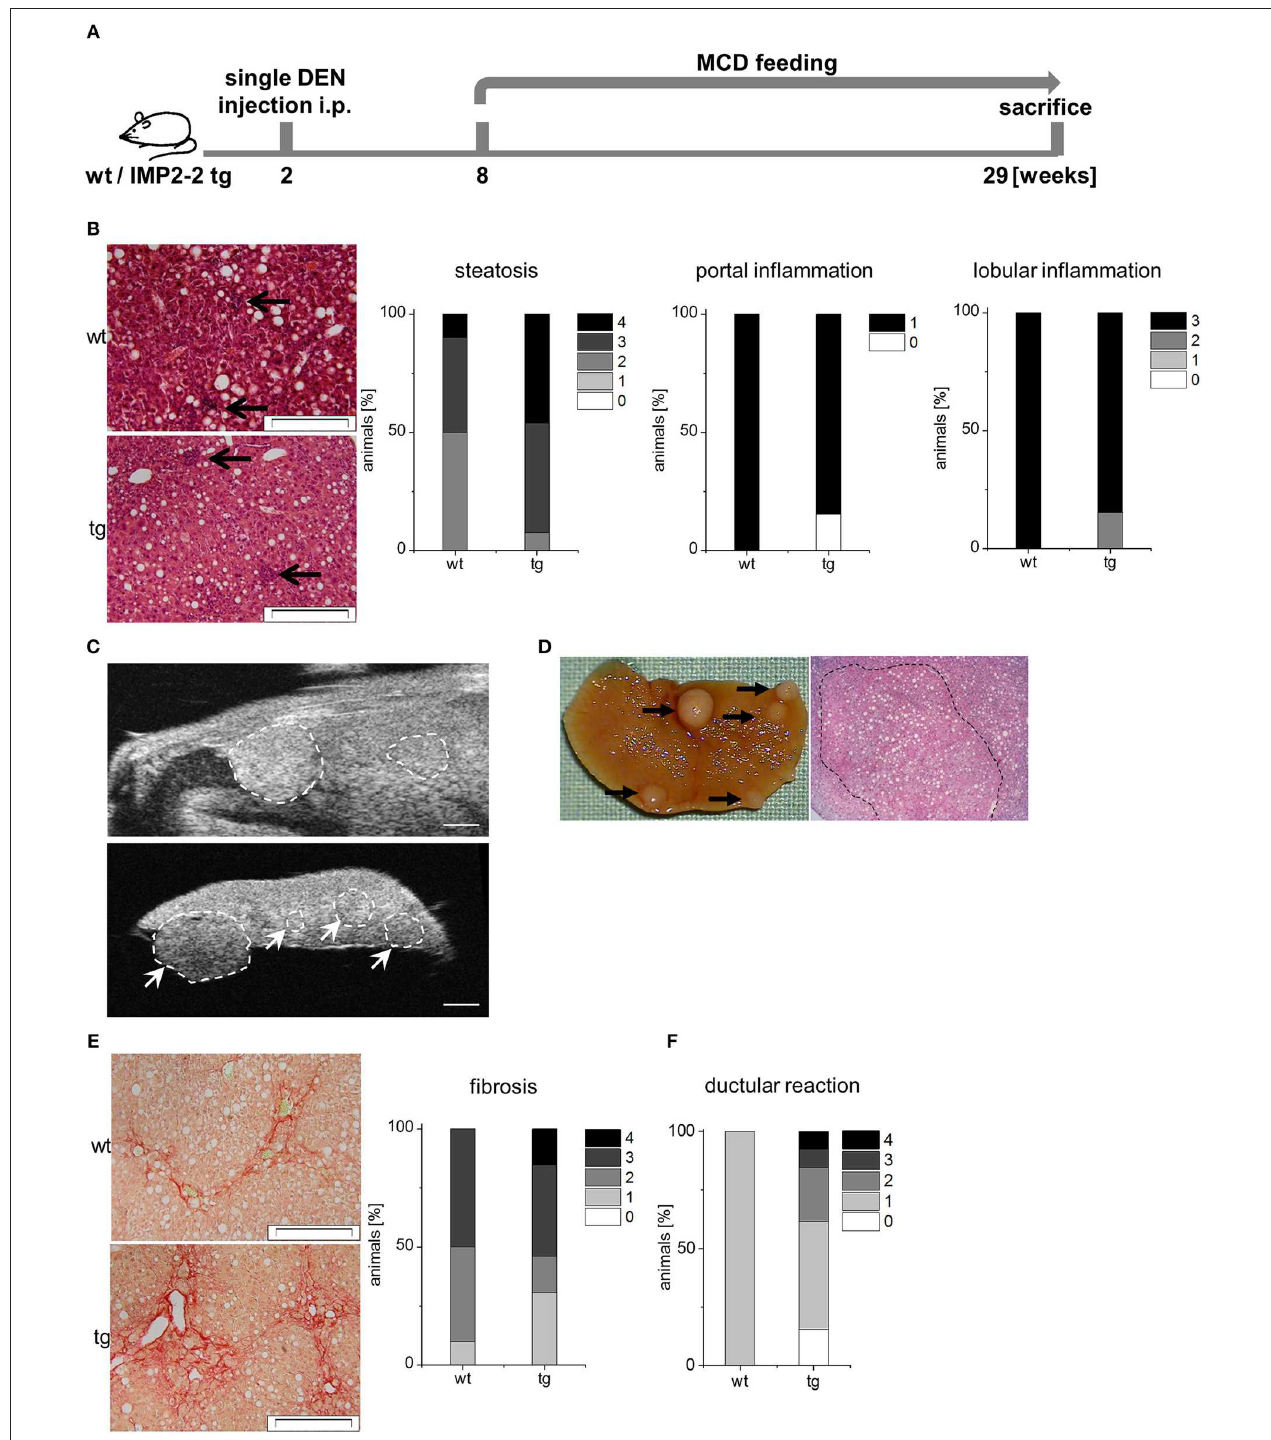
FIGURE 6 | IMP2-2 triggers cirrhotic changes in the DEN-MCD model. (A) Treatment scheme of the DEN/MCD model. Administration of diethylnitrosamine (DEN) 6 weeks before the onset of MCD feeding (DEN-MCD). (B) Representative images of HE (left) and histological scorings for steatosis, lobular and portal inflammation of wt and tg mice treated with DEN-MCD. Arrows indicate inflammatory foci (scale bars: 50 µ m). (C,D) Representative images of high-resolution ultrasound (C) and macroscopic view (D) of a liver of DEN-MCD mice. (C) High-resolution ultrasound imaging of an in situ (upper image) and ex situ (lower image) liver. Scale bars 0.9mm (upper image), 1.2mm (lower image). (E) Representative images of Sirius Red staining (left) and histological scoring for fibrosis (right) of wt and tg mice treated with DEN-MCD (wt: n = 10, tg: n = 13) (wt: score 2; tg: score 4; scale bars: 50 µ m). (F) Histological scoring of KRT19 staining for DR (right) of wt and tg mice treated with DEN-MCD (wt: n = 10, tg: n =